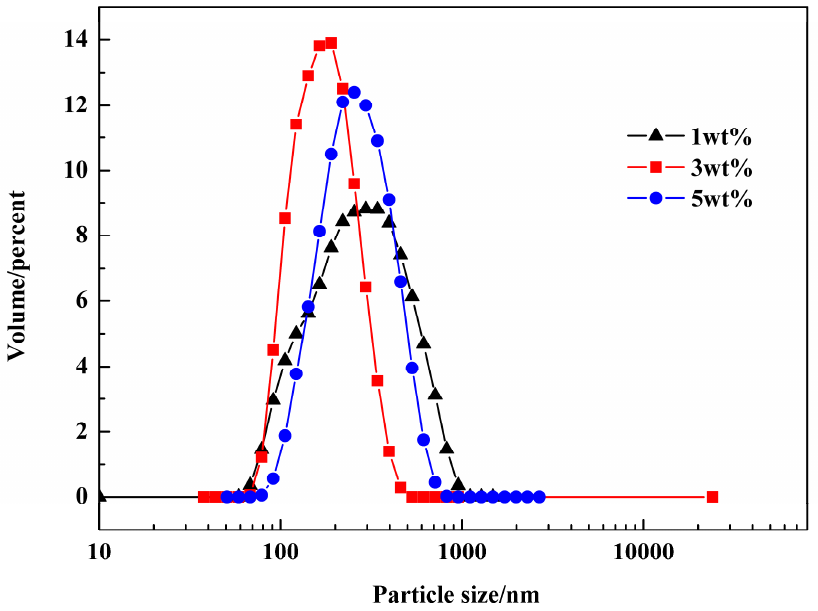
Figure 11. Particle size distributions of PR 146 obtained from miniemulsions containing different dosages of emulsifier.